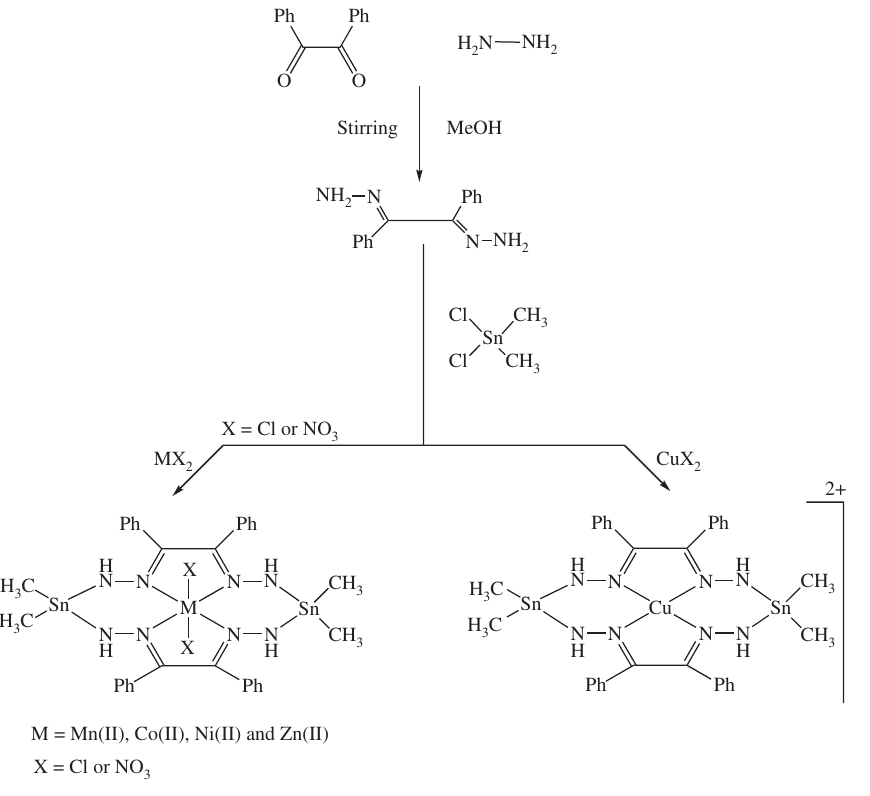
Scheme 1: Formation and suggested structure of tin(IV) macrocyclic